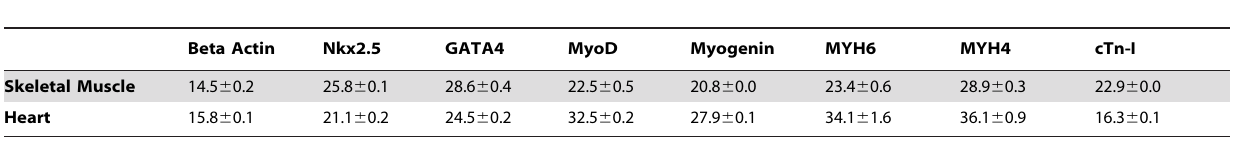
Table 1. Cycle to threshold (Ct) Values of cardiac and skeletal muscle transcription factor and structural muscle protein gene expression of Embryonic day 13 (ED13) ventricular myocardium and skeletal muscle